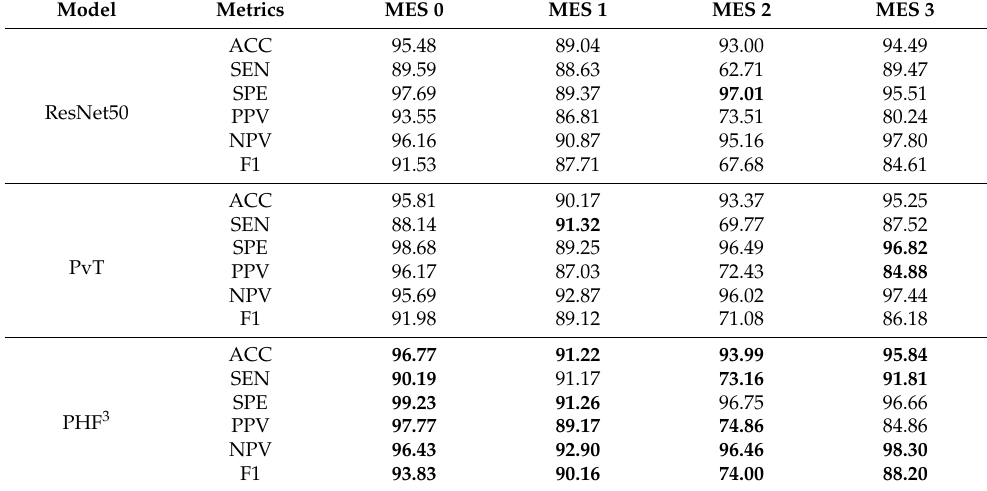
0.990, respectively. Table 4. The ablation study.